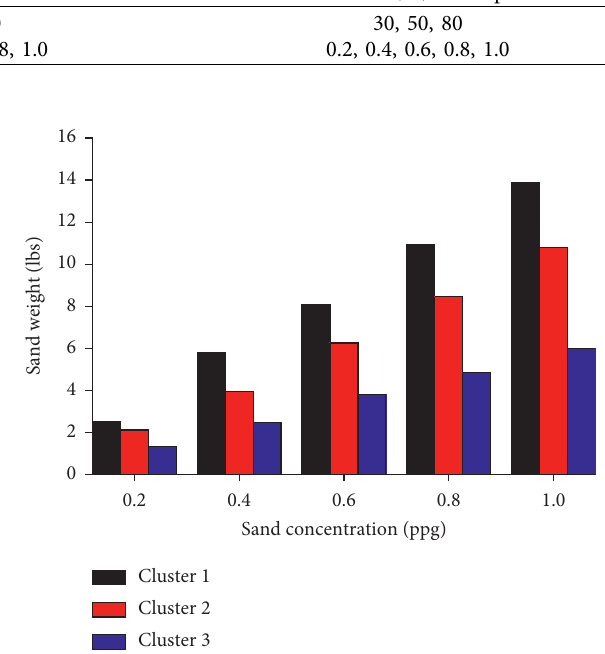
Figure 3: Sand distribution along perforation clusters at a pumping rate of 30